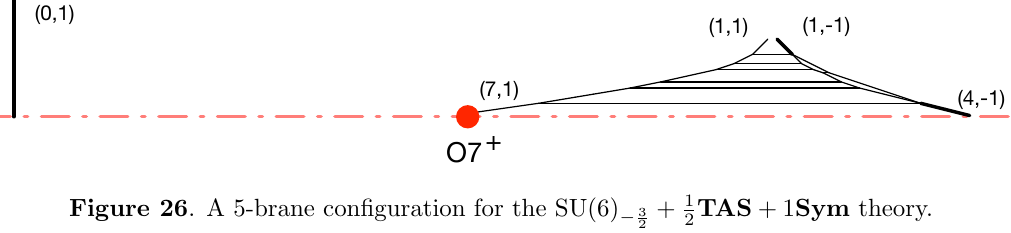
+ 1 TAS + 1 Sym theory. (cid:0) 3 2 2